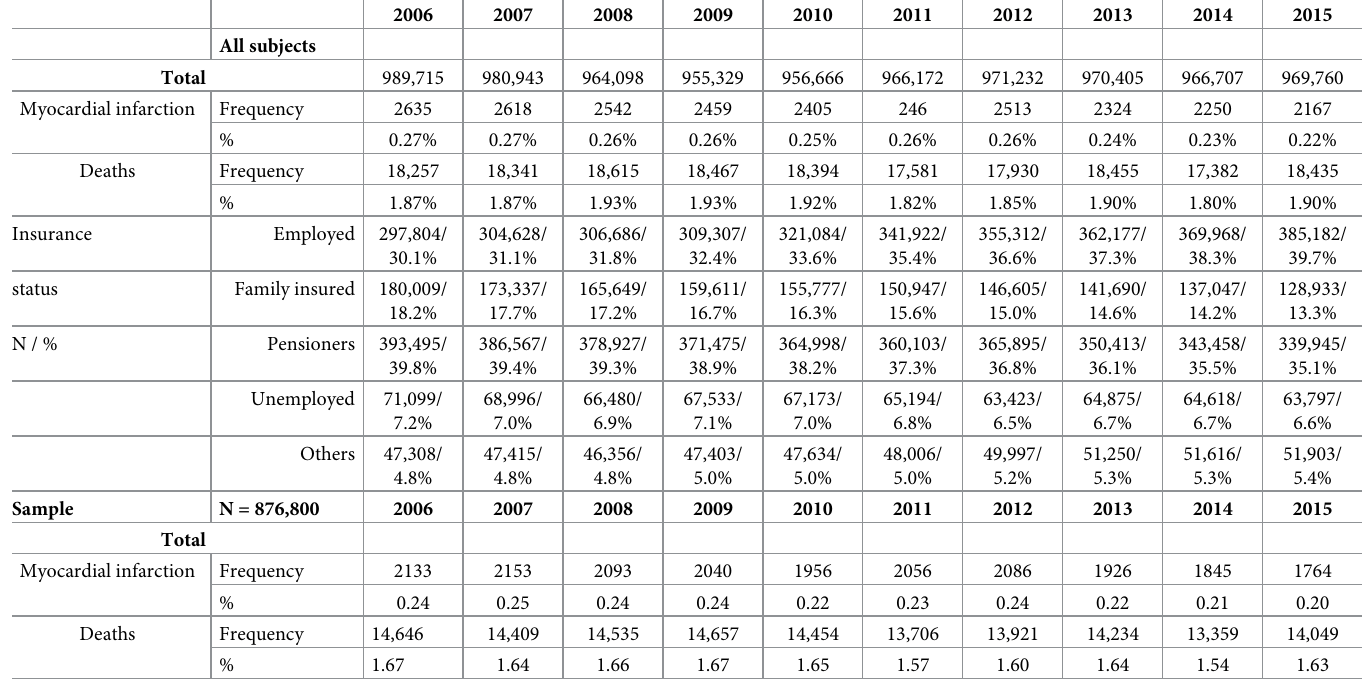
Table 2. Distribution of the variables used of the complete female population (survival analyses) and for sample-based analyses (age at MI-onset and age at